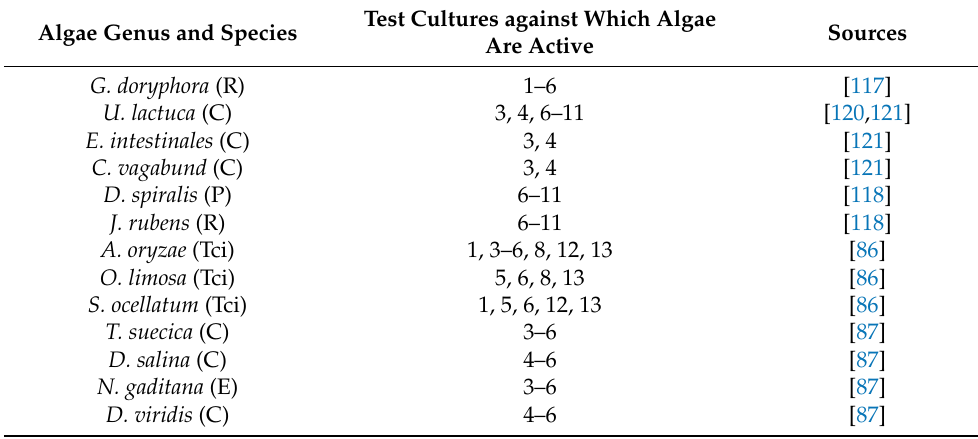
Table 2. Antimicrobial activity of various algae. Algae Genus and